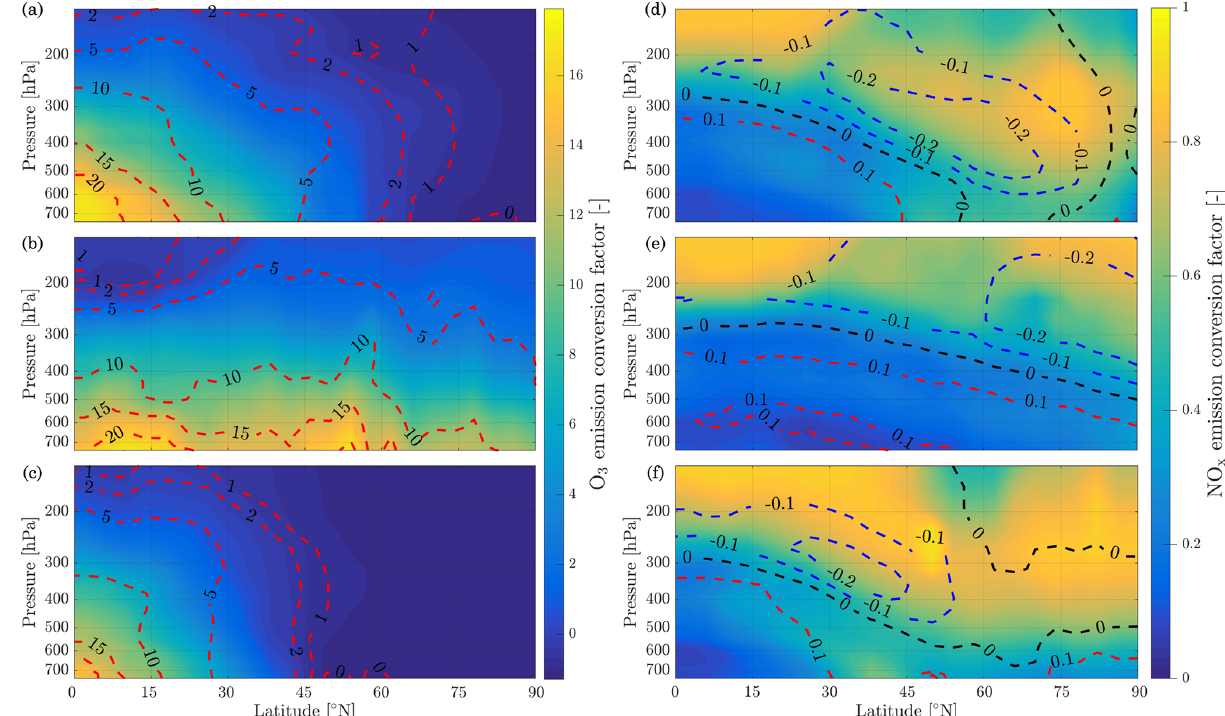
Figure 10. Contour plots of O 3 (a) and NO x (b) conversion emission factors, 24h after emission from APCEMM. The isolines represent the discrepancy between the instant-dilution approach and APCEMM. Blue isolines represent cases where the species ECF is underestimated, whereas the red isolines signify that the quantity is overestimated by instant dilution. Simulations have been carried out for emissions at 08:00LT on 21 March, 21 June and 21 December (from panel a to b